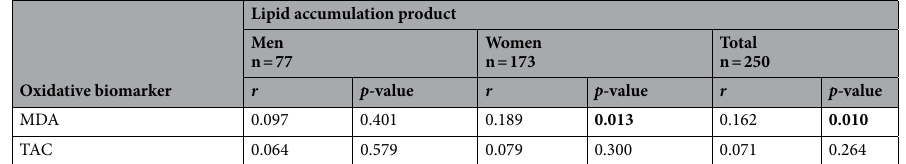
Table 2. Correlations between LAP and oxidative stress biomarkers malondialdehyde (MDA) and total antioxidant capacity (TAC) among men (n = 77) and women (n = 173). MDA: malondialdehyde; TAC: total antioxidant capacity. p-value less than 0.05 was considered statistically significant.